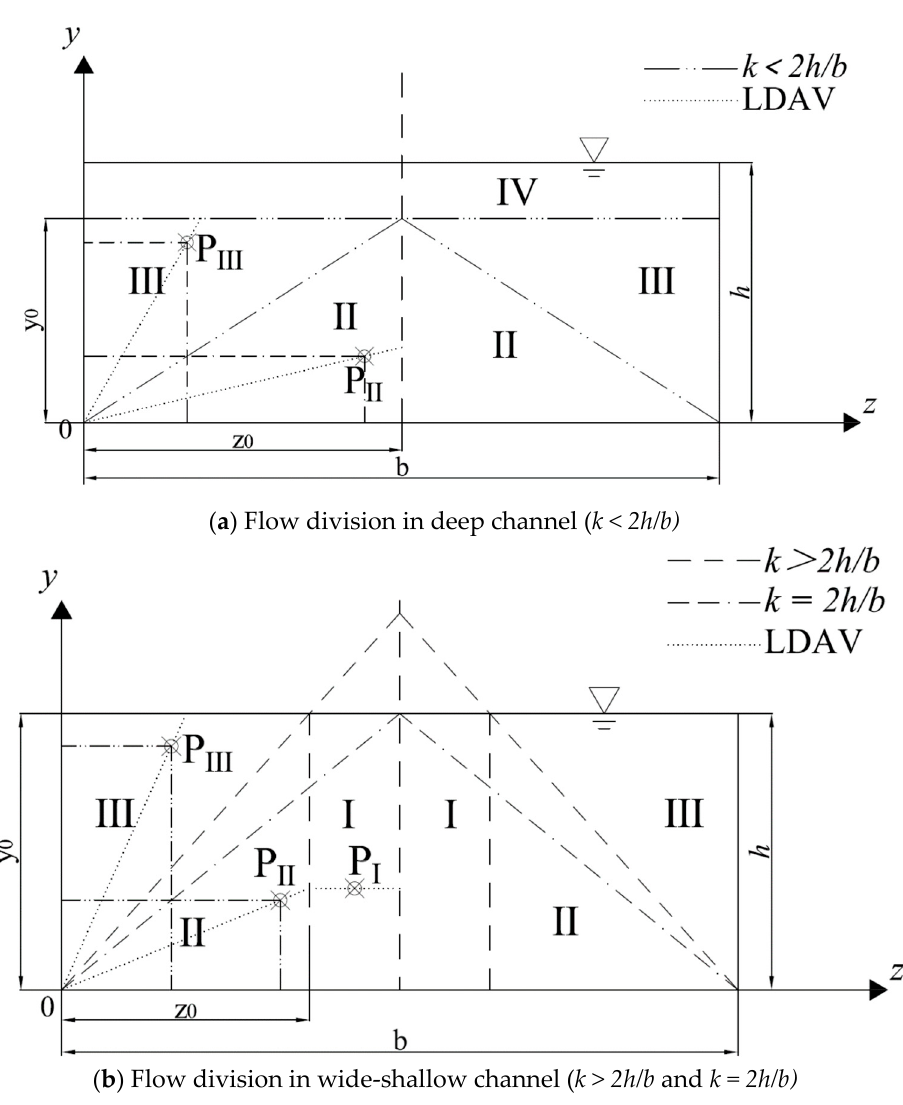
Figure 4. Location map of the characteristic points and the line of depth average velocity (LDAV) in different flow partitions.